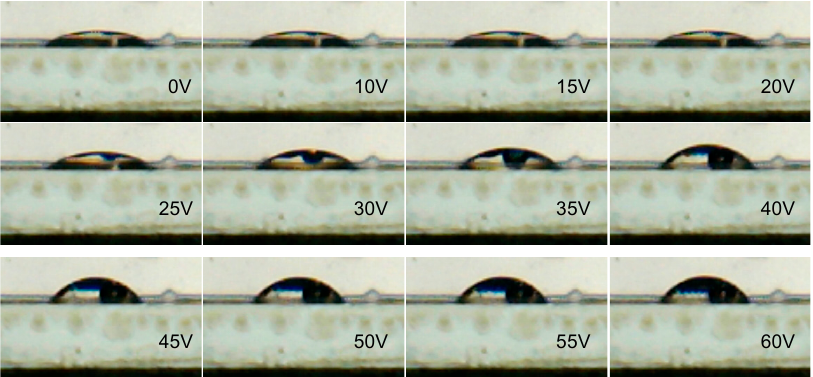
Figure 4. Voltage-dependent shape change of the liquid droplet. A dynamic video showing the shape change of the droplet is given at V = 45 V rms .